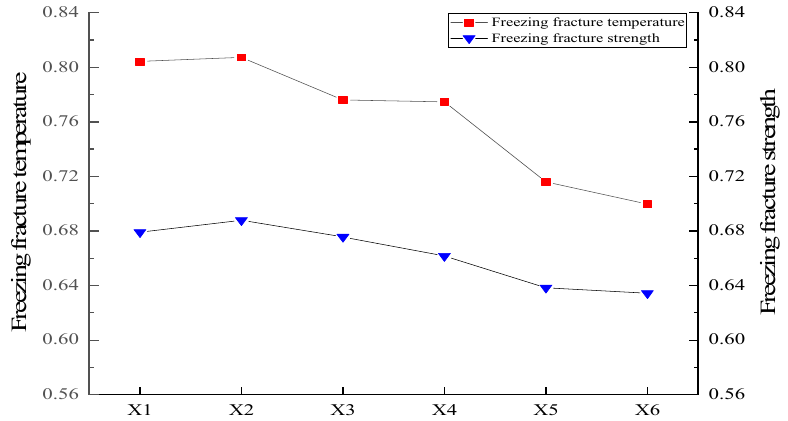
Figure 7. Correlation coefficient between different properties at low temperature.